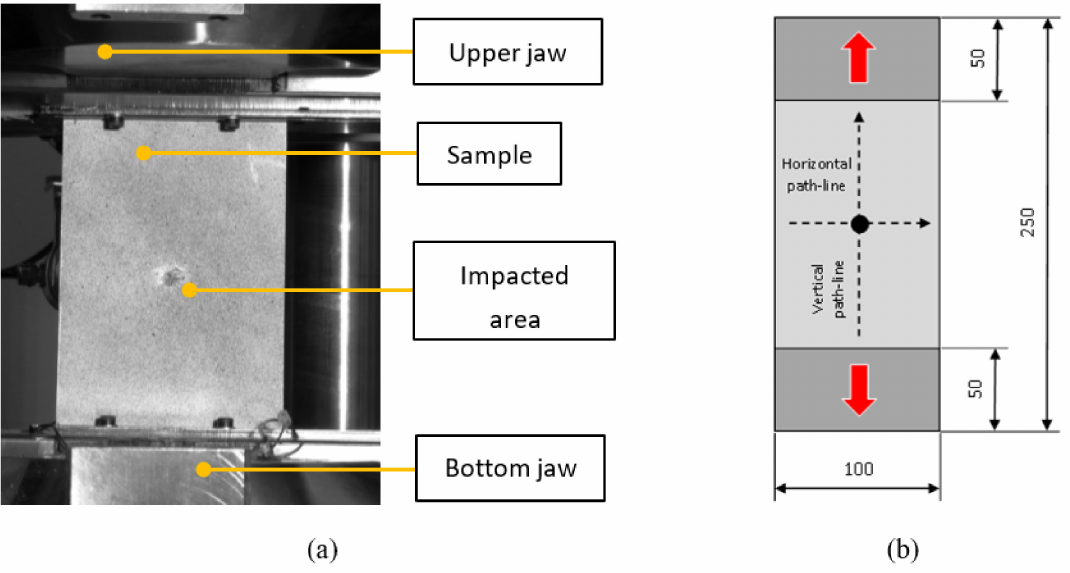
Figure 6. Post-impact tensile test; Experiment ( a ); Sample with paths and dimensions ( b